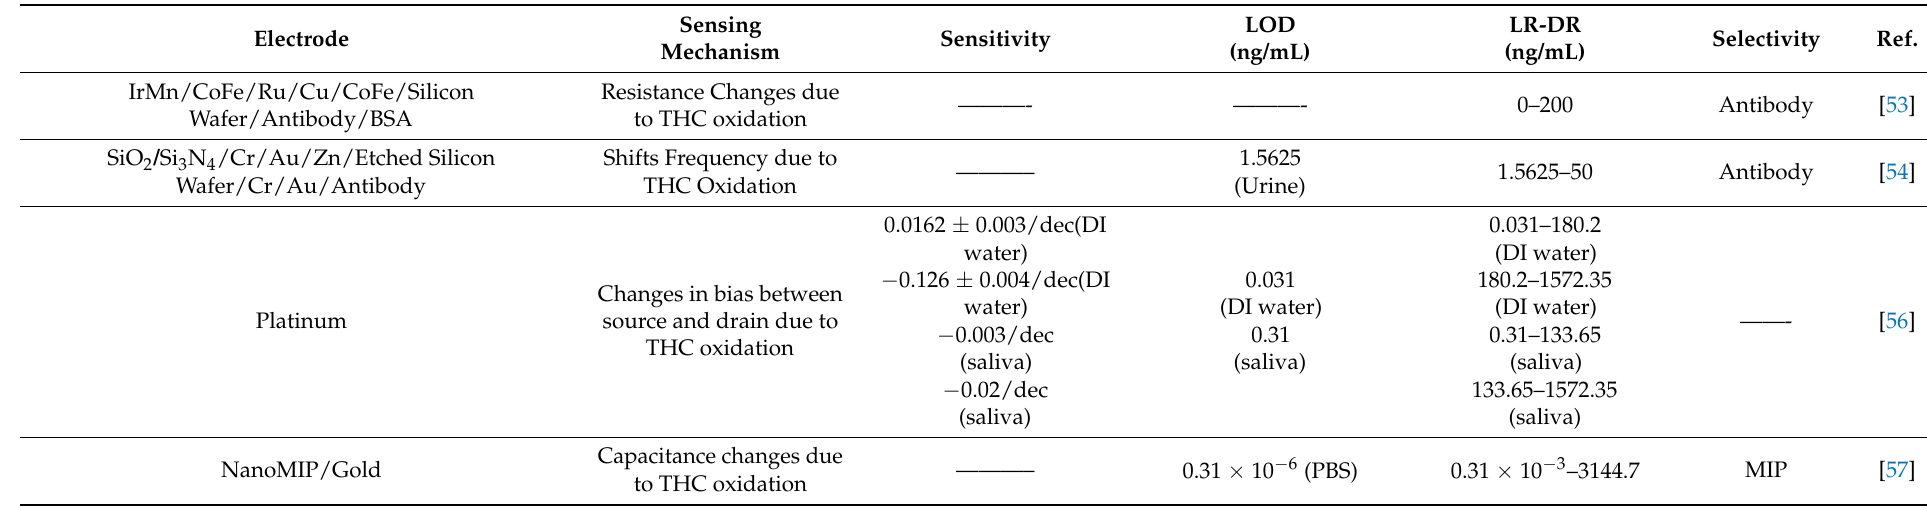
Table 6. A comparison between alternative sensors for detecting ∆ 9 -THC in terms of working electrode material, sensing mechanism, and sensing